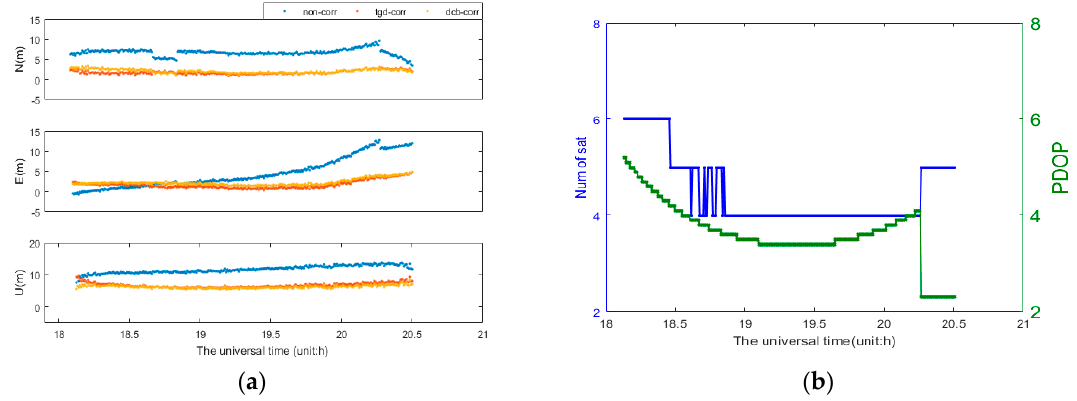
Figure 4. Galileo-only b1-based SPP positioning errors of BRUX for three different processing cases ( a ); and Satellite number and PDOP at BRUX ( b ).